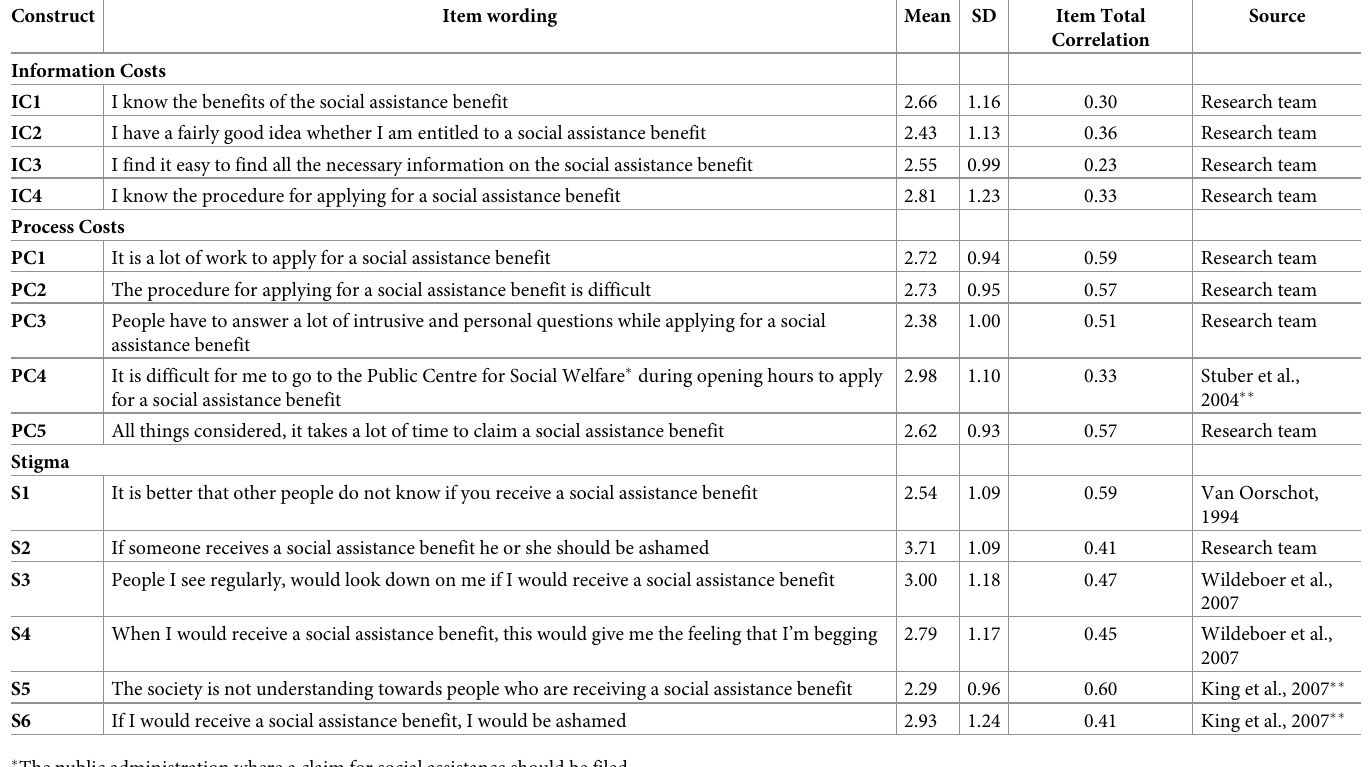
Table 2. Items, mean, standard deviation, item-to-total correlation and item